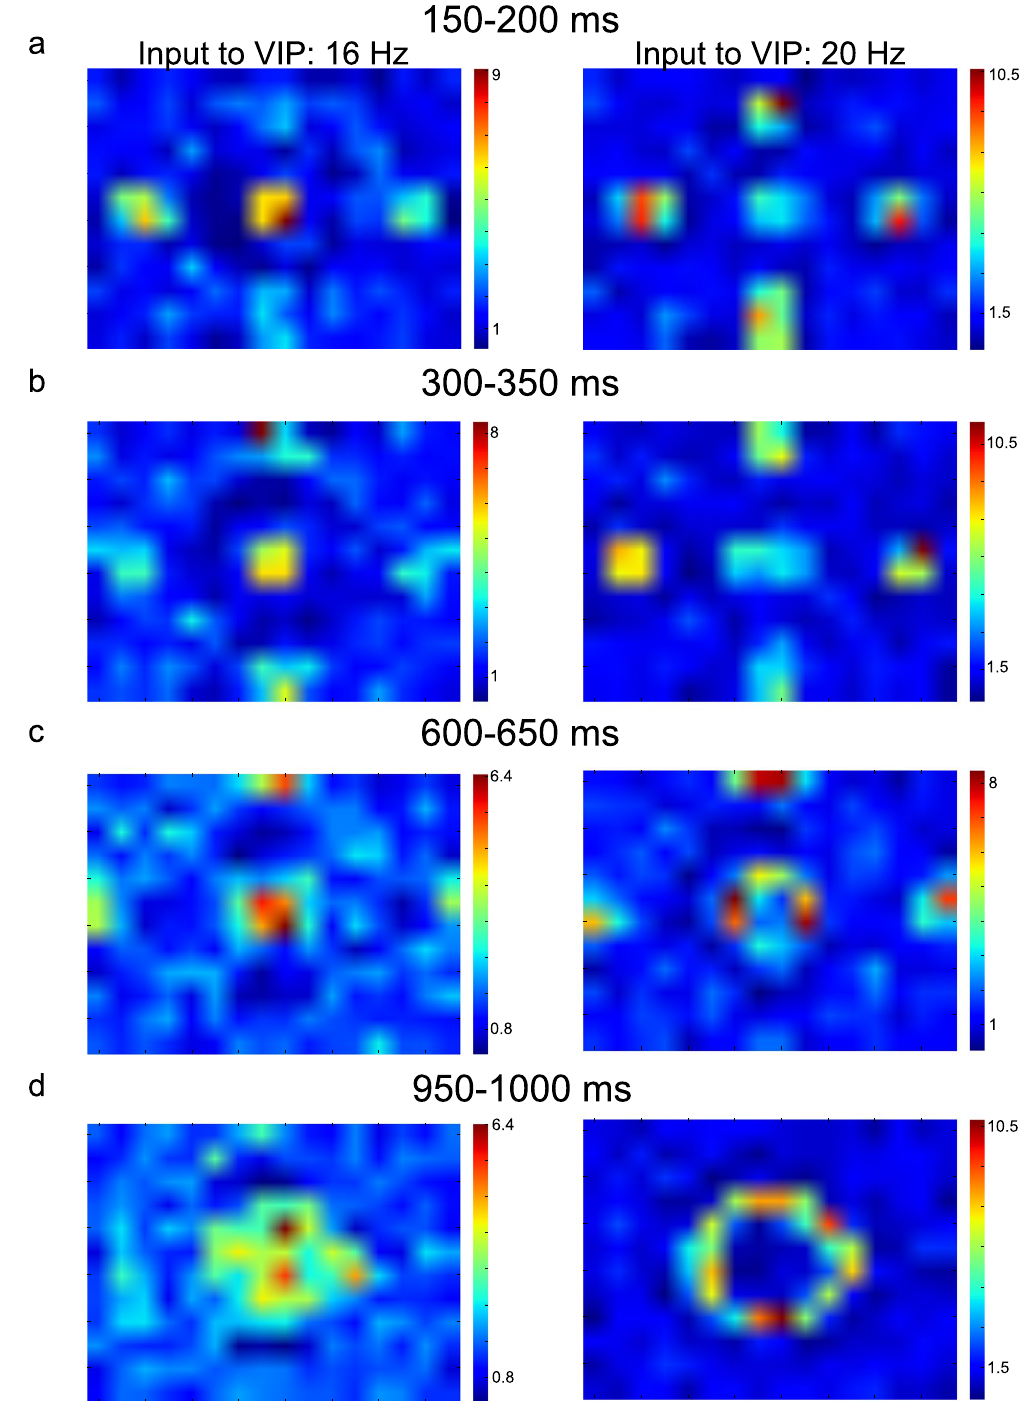
Figure 7. Column responses in the computational model. (a–d ) Column responses averaged over 10 independent simulations in four different 50 ms time windows, respectively. The left and right columns show them with low and high external inputs to VIP cells. The color bars show the firing rate of Pyr cells in